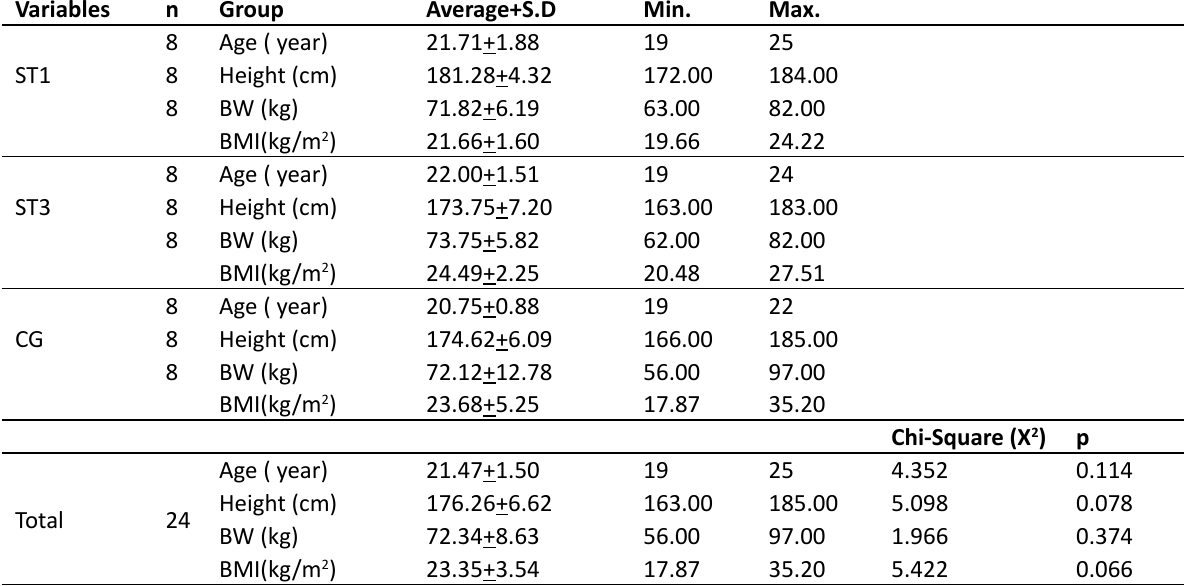
Table 1. Descriptive statistics of participants.